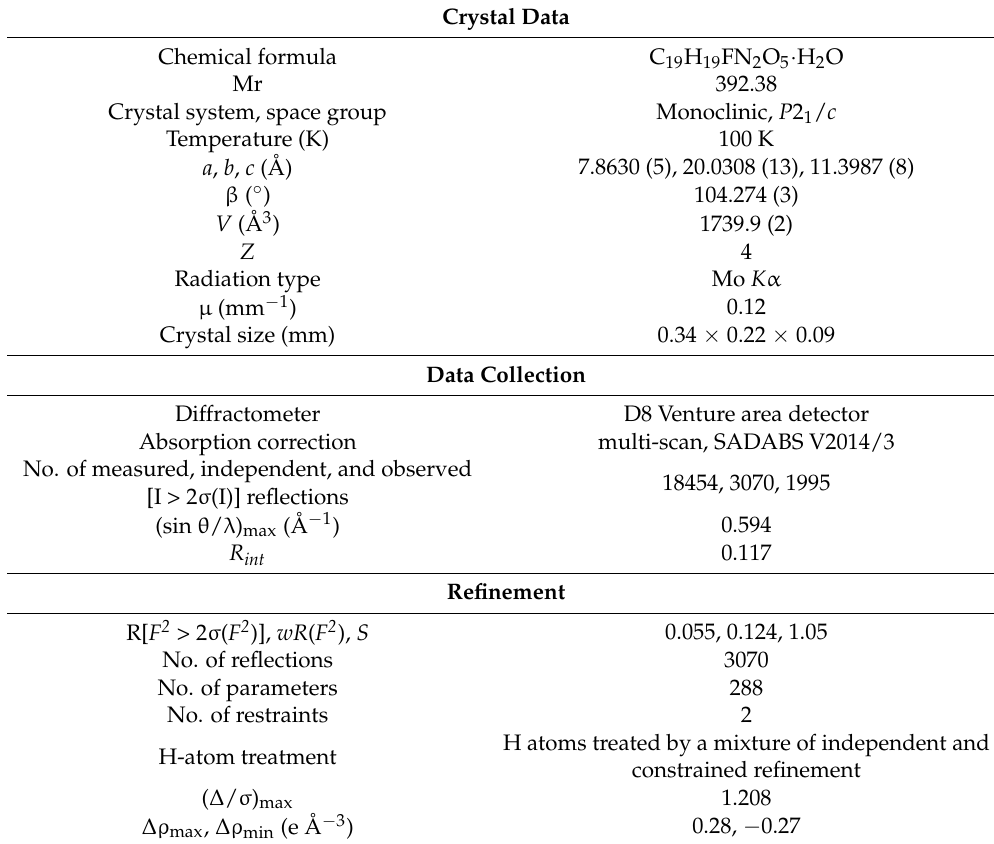
Figure 2. H-bonding network in the crystal structure of the title compound viewed as 3D network; dotted lines indicate intermolecular interactions. Table 1. Crystal data, data collection, and refinement.